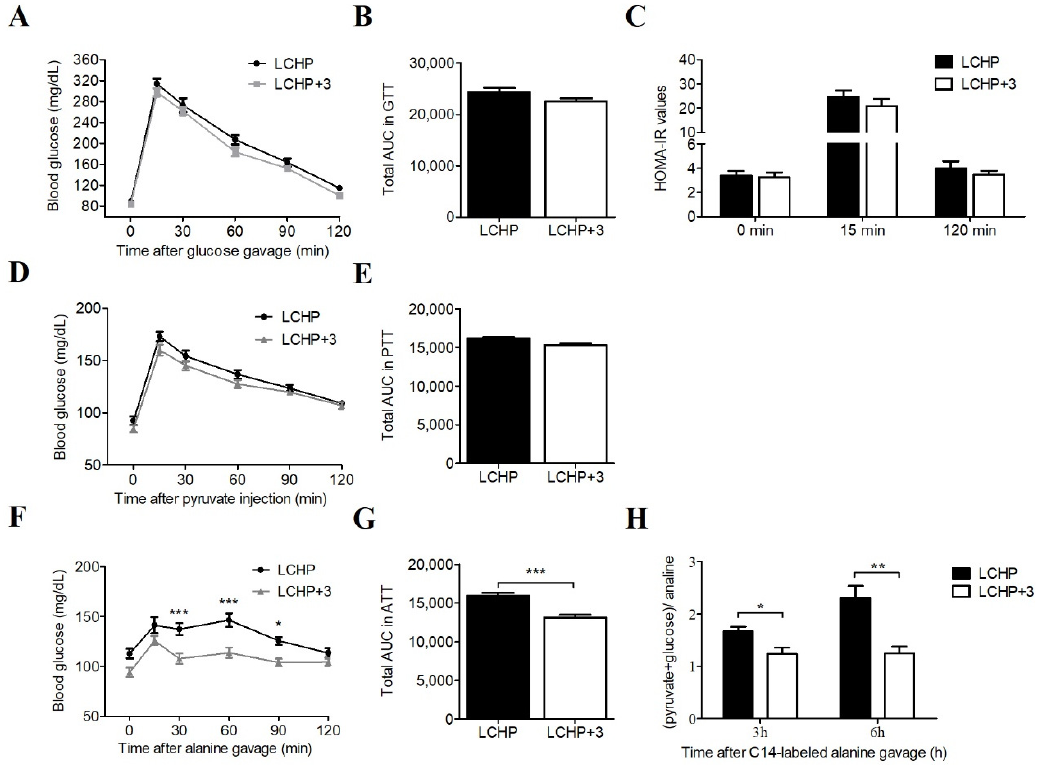
Figure 3. Effects of the LCHP+3 diet on the glycemic control and amino acid gluconeogenesis. ( A ) Blood glucose during GTT, n = 12; ( B ) Total AUC in GTT, n = 12; ( C ) HOMA-IR values in GTT, n = 12; ( D ) Blood glucose during PTT, n = 12; ( E ) Total AUC in PTT, n = 12; ( F ) Blood glucose during ATT, n = 12; ( G ) Total AUC in ATT, n = 12; ( H ) 14 C-radiolabeled alanine conversion, n = 6 in each time point. GTT, glucose tolerance test; PTT, pyruvate tolerance test; ATT, alanine tolerance test; AUC, area under the curve; HOMA-IR, homeostasis model assessment of insulin resistance; LCHP, low-carbohydrate/high-protein/low-omega-3; LCHP+3, low-carbohydrate/high-protein/high-omega-3. Values are shown as mean ± SEM; * p < 0.05; ** p < 0.01; *** p < 0.001.